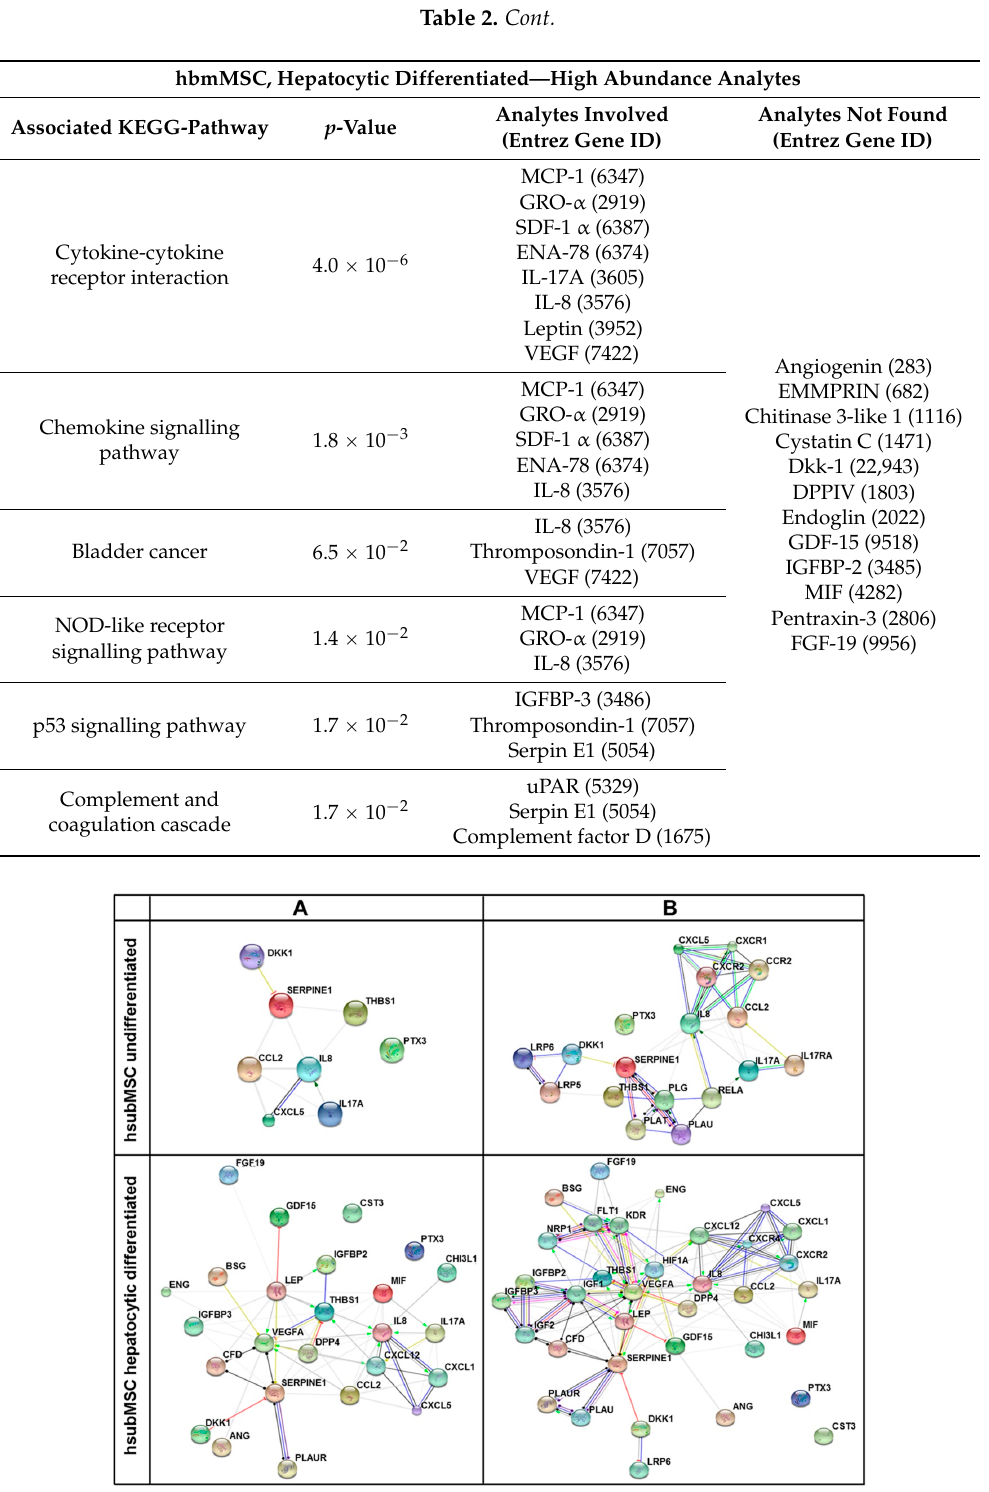
Figure 7. Network of interacting cytokines ( A ) and additional 10 predicted potential interaction partners ( B ) of undifferentiated ( upper panels) and hepatocytic differentiated ( lower panels) hsubMSC. Networks were created by the STRING database using only proteins secreted at high abundance as summarised in Tables S2 and S4. Connections between partners are shown in different colours; green : activation, red : inhibition, blue : binding, cyan : phenotype, violet : catalysis, pink : posttranslational modification, black : reaction, yellow : expression. Bubble colours are only for a better discrimination.